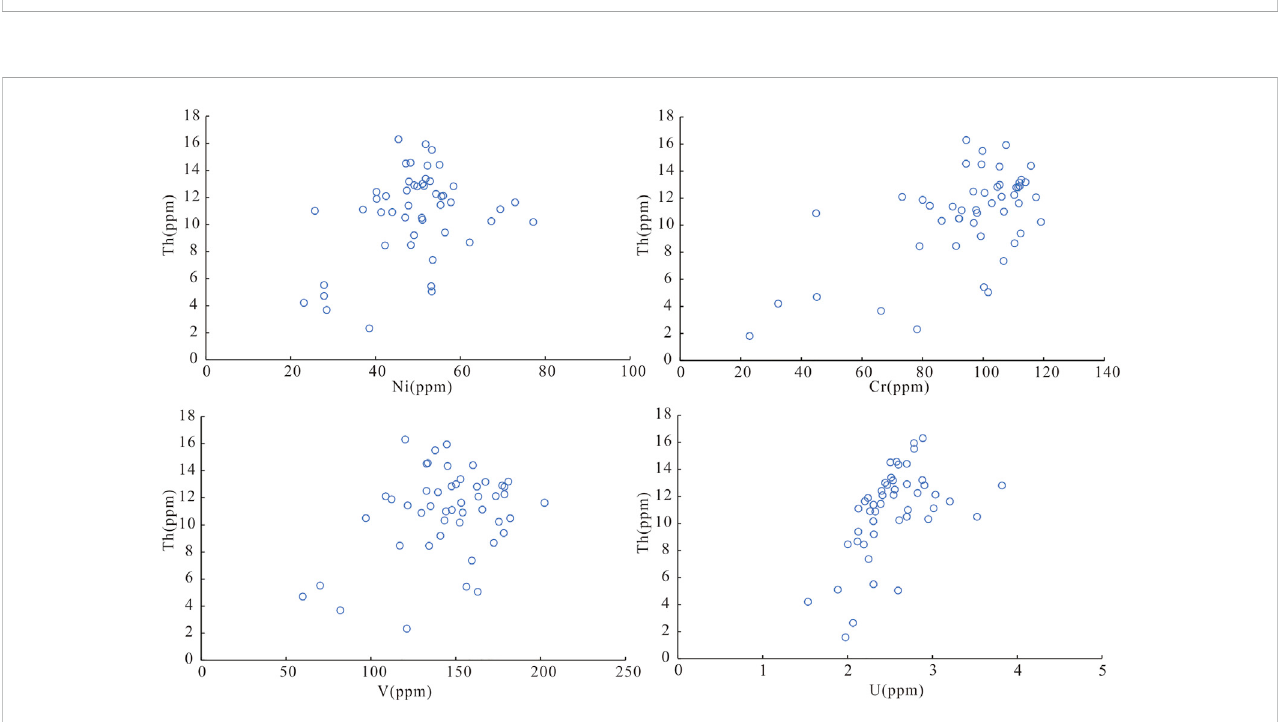
FIGURE 6 Binary cross-correlation plots of Th – Ni, Cr, V, and Th –